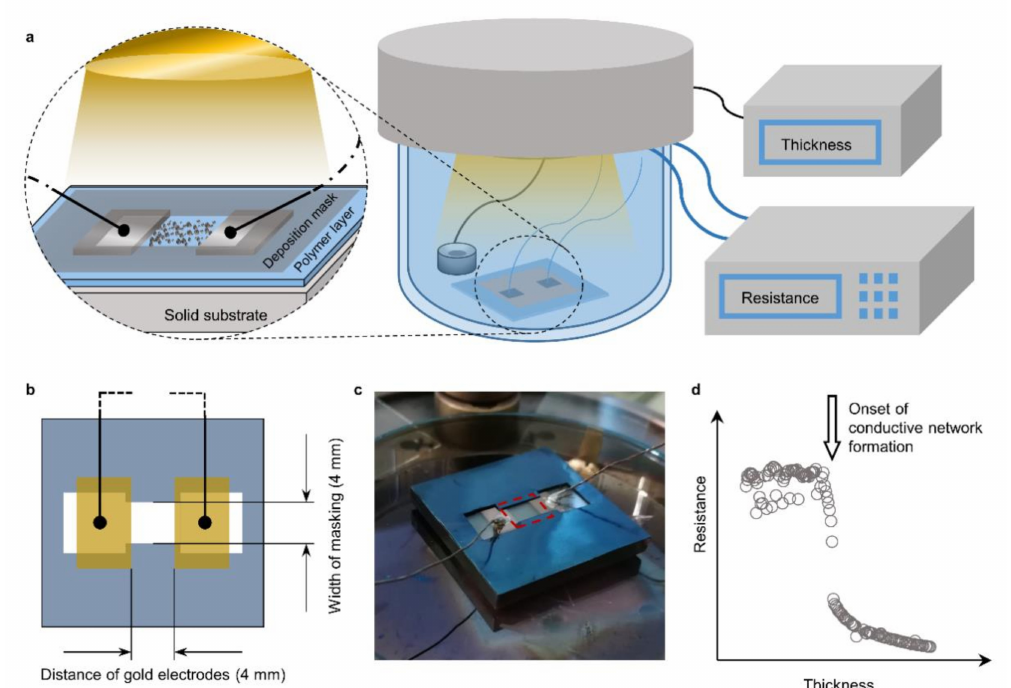
Figure 1. In situ resistance measurement setup. ( a ) Schematic representation of the general setup (right side) with a detailed representation of the sampling area; ( b ) geometry of the growing film between the gold electrodes confined by the masking; ( c ) optical image of a contacted sample sitting on the sample stage. The 4 × 4 mm area of measured thin film is indicated by a red dashed rectangle; ( d ) typical results obtained by relating the resistance to the thickness both measured in